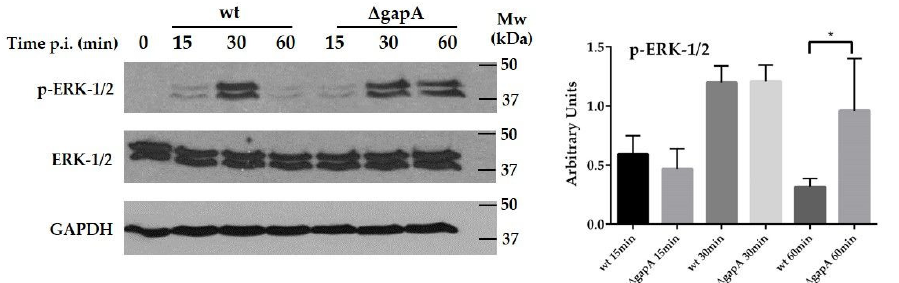
Figure 9. Western blot analysis of ERK 1/2 MAPK kinase in BMDMs infected with wt or ∆ gapA at MOI 50 for 15, 30, and 60 min. Representative Western blots are shown. Bands were quantified using ImageJ (right panel, n = 4 blots). Data shown as mean ± SEM were analyzed using one-way ANOVA (* = p ˂ 0.05).